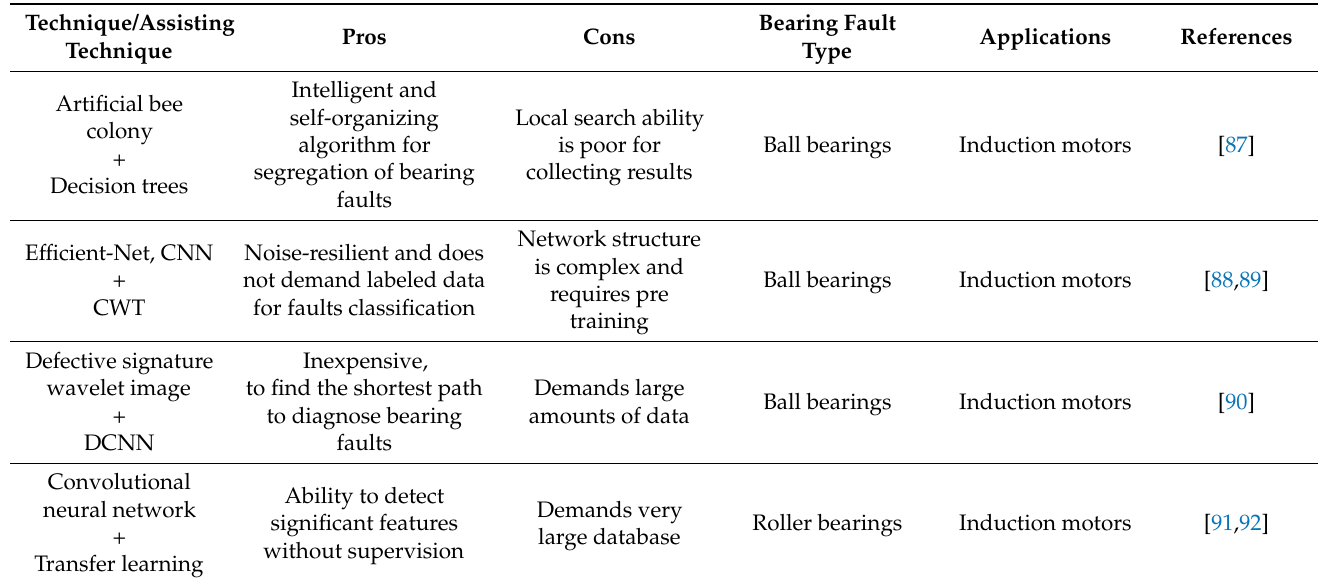
Table 3. A summary of different artificial intelligence techniques for bearing fault